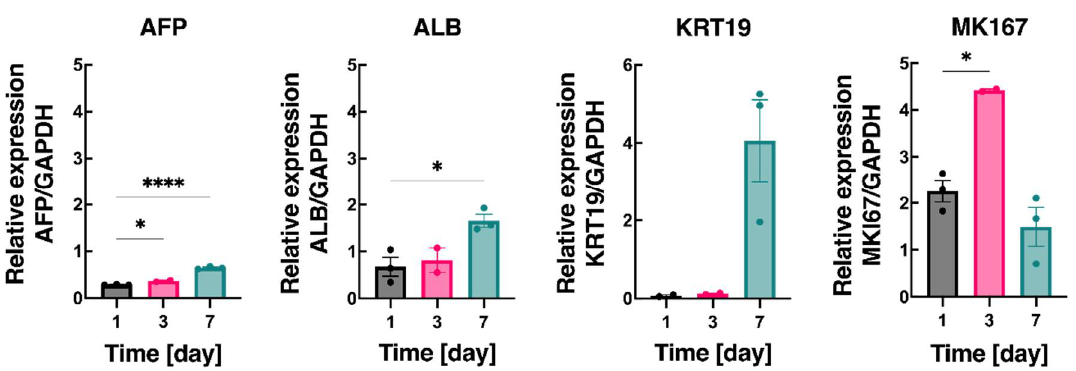
Figure 6. Gene expression analysis is relative to GAPDH of AFP, ALB, KRT19, and MKI67 at various time points. All experiments were conducted in triplicate. Error bars show the standard error of the mean (* p < 0.05 and **** p < 0.0001).